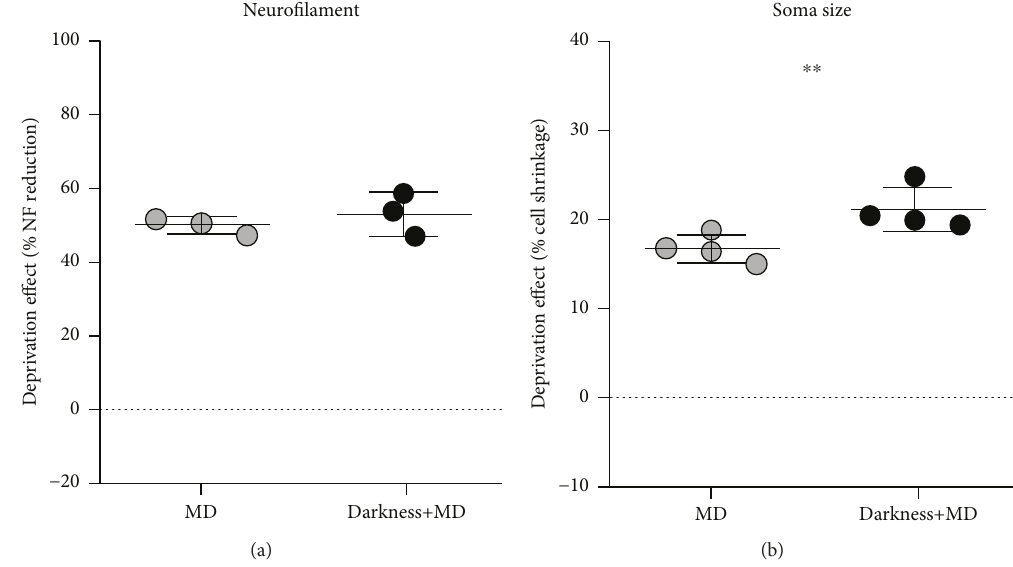
Figure 4: Comparison of the MD e ff ect between MD-only and dark exposure followed by MD conditions. Whereas comparison of the e ff ect of MD on neuro fi lament labeling across conditions indicated that the loss in the dLGN was similar with or without darkness (a), the e ff ect on soma size was signi fi cantly larger in the group of animals that received dark exposure prior to MD (b). Asterisks indicate statistical signi fi cance at probability < 0 05